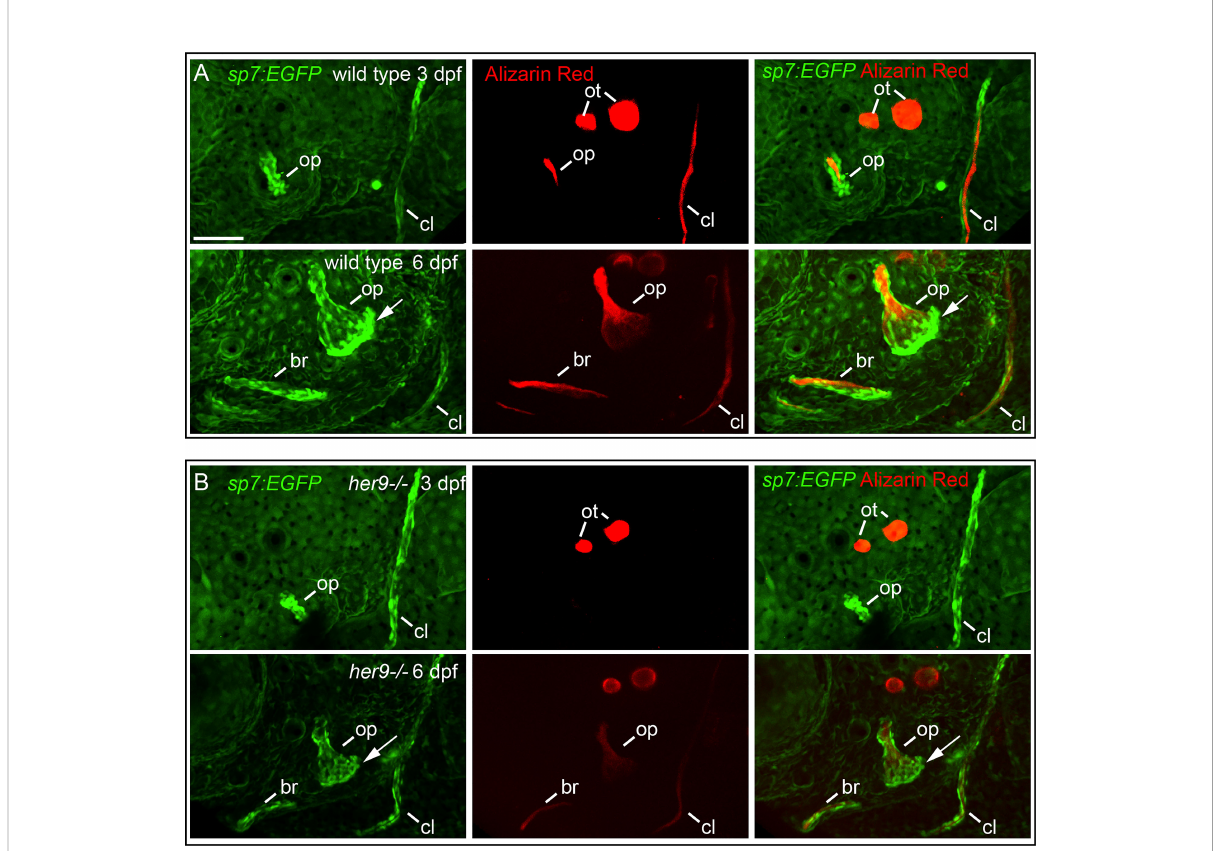
FIGURE 4 Osteoblasts differentiate in a spatiotemporal pattern similar to wild types in her9 mutants, but only weakly mineralize bone. sp7:EGFP ; her9 heterozygotes were crossed to her9 heterozygotes and offspring were sorted for transgene expression. 16 live transgenic animals were labeled with Alizarin Red and imaged at 3 dpf. After imaging, animals were recovered and grown in individual wells until 6 dpf when they were labeled with Alizarin Red and imaged again. Individual animals were recovered for genotyping to identify homozygous wild types (A) and homozygous her9 mutants (B) that were imaged twice. The following structures are indicated: opercle bone (op), branchiostegal ray (br), cleithrum (cl), otoliths (ot). Arrows indicate osteoblasts prominently detected along the ventral edge of the opercle at 6 dpf. Scale bar is 50 m